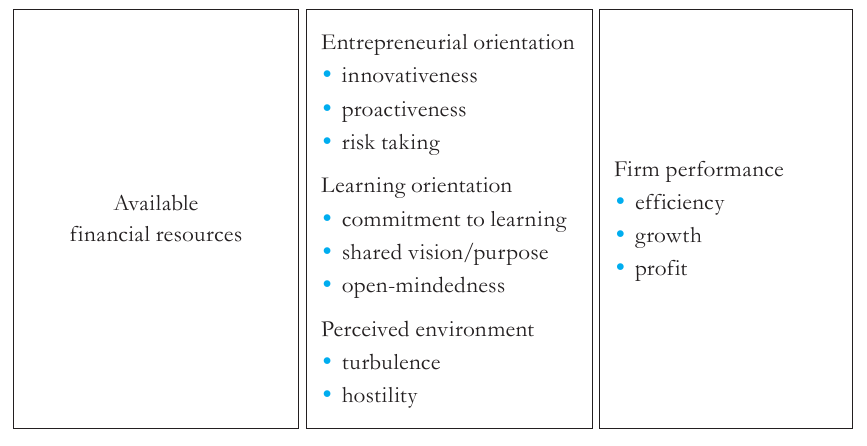
Fig. 1 – The examined dimensions. Source: own